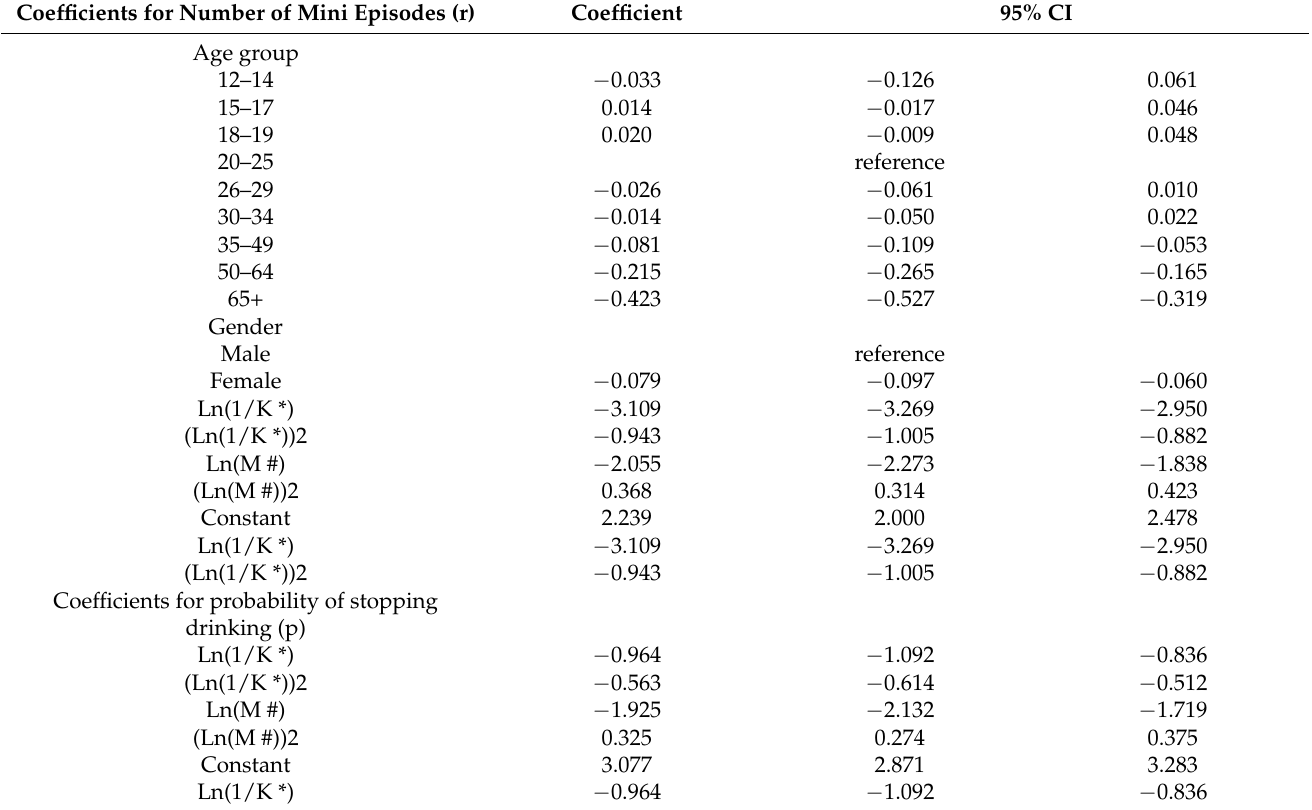
Table 3. Estimated model coefficients for calculation of (i) number of mini episodes (r) and (ii) probability of stopping drinking